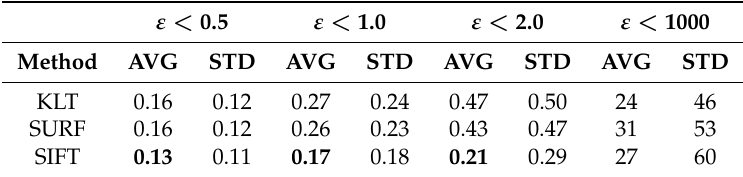
Table 3. Statistic details of vertical misalignment ε = | y L − y R | in pixels between correspondences found by KLT, SURF and SIFT on 2005 and 2006 Middlebury stereo datasets. ε < 0.5 ε <